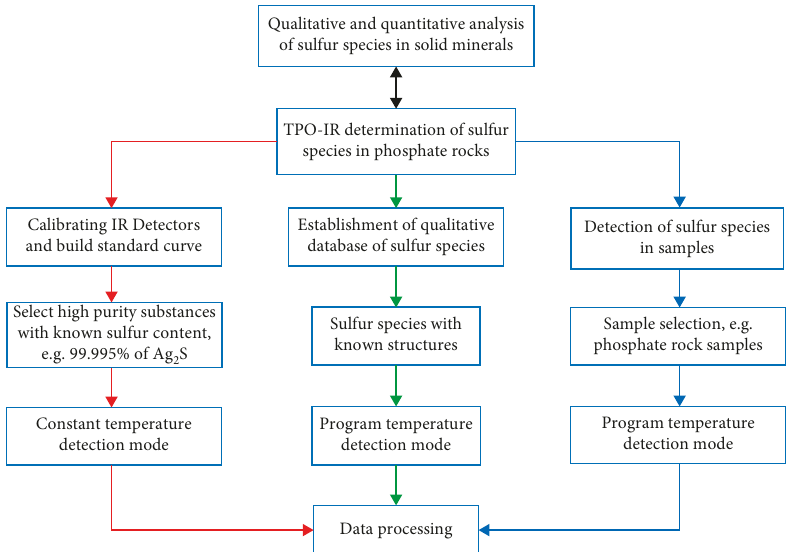
Figure 2: Flow diagram of sulfur species measurement using the TPO-IR